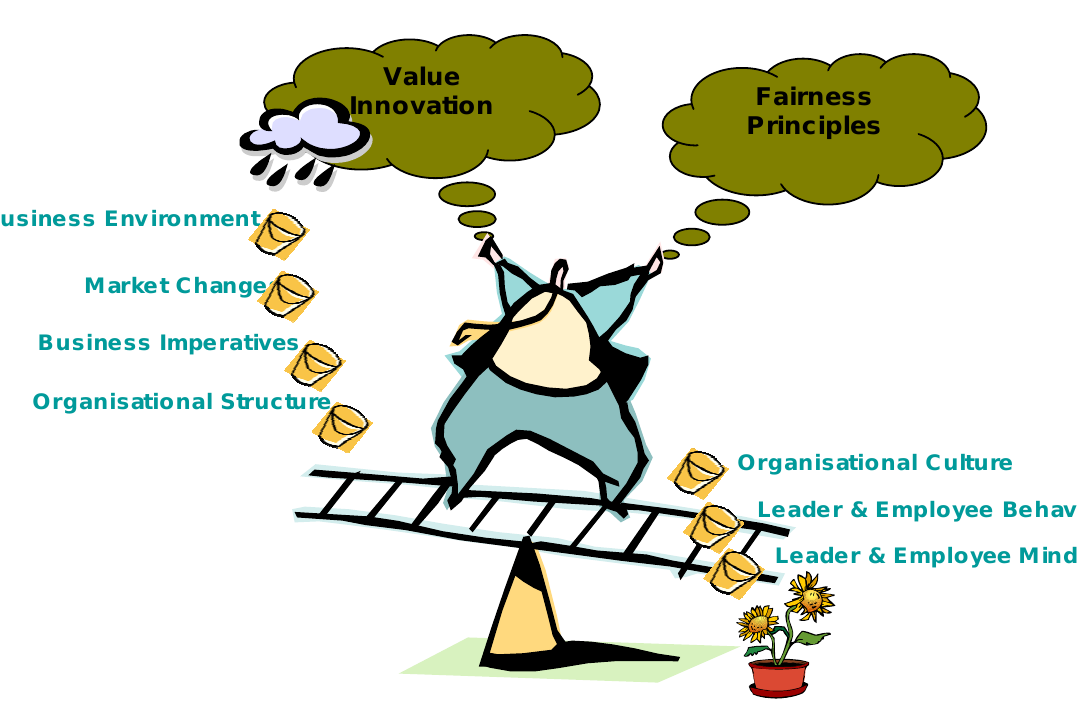
Figure 1: The See-Saw Model